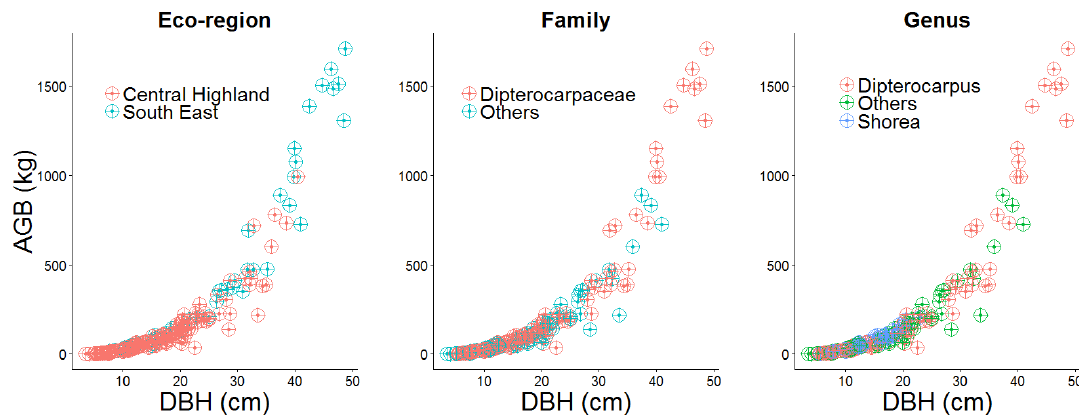
Figure 2. AGB vs. DBH of destructively sampled trees by ecoregion, plant family, and genus. The trend